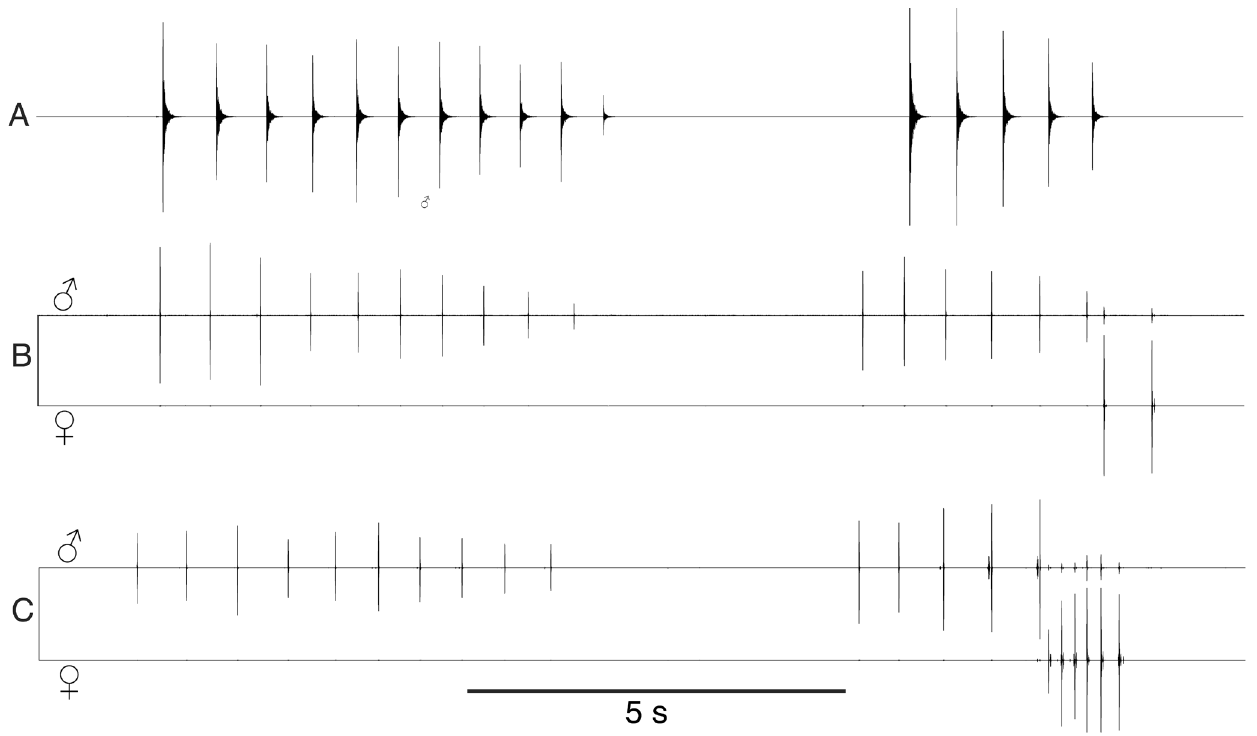
Fig. 6. Oscillograms of: A . the spontaneous male calling song, and B, C. of two-channel recordings of male-female duets ( B : Female response with few impulses; C : With many impulses).